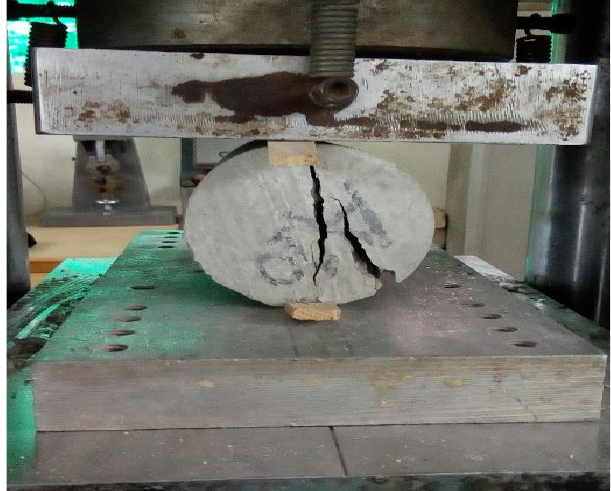
Fig. 11. Splitting tensile